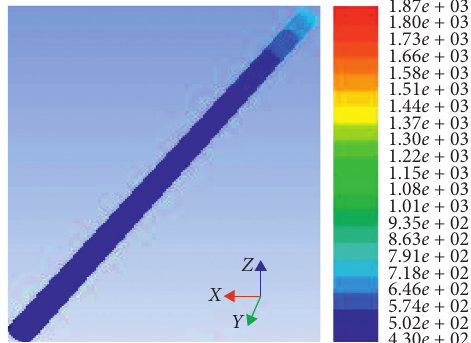
Figure 18: Temperature cloud diagram of the threaded pipe.